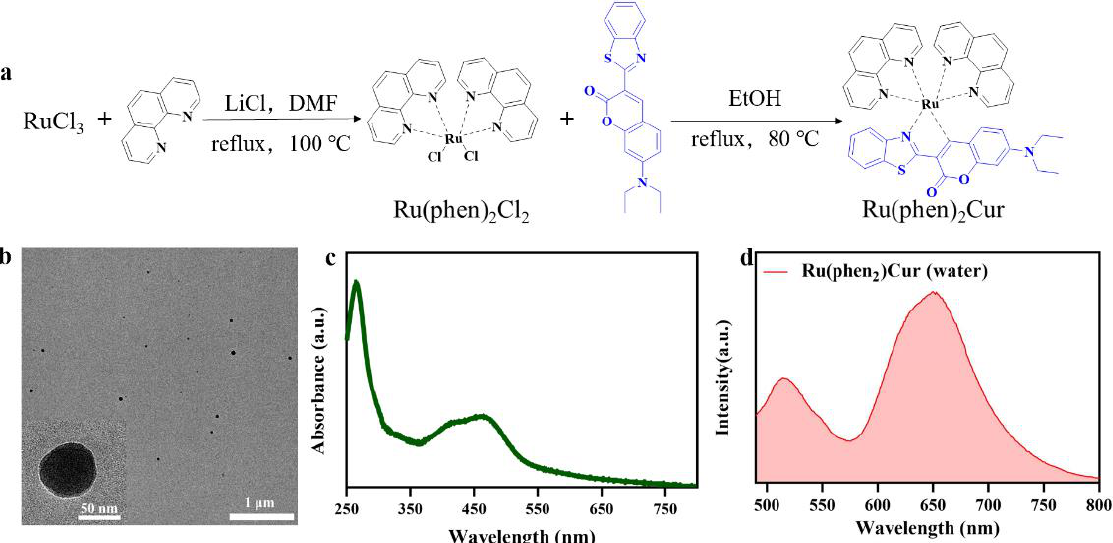
Figure 1. Scheme of Ru(II)-coumarin complexes preparation and characterization of RuCM NP. ( a ) Scheme of Ru(II)-coumarin complexes preparation. ( b ) TEM images of RuCM NP. Scale bars are 1 μm and 50 nm (inset), respectively. ( c ) UV-Vis absorption spectra of RuCM NP. ( d ) Fluorescence spectra of RuCM NP with the λ ex = 450 nm.